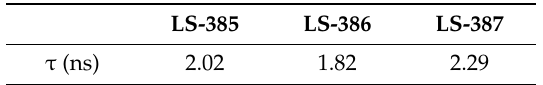
Table 6. The excited state lifetime of ( τ , in ns) in DMF solvent.